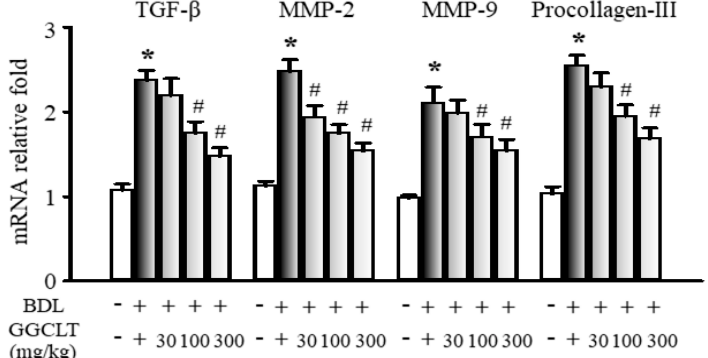
Figure 5. E ff ects of GGCLT on hepatic fibrotic signaling in BDL mice. The quantitative real-time PCR results show the mRNA levels of TGF- β , matrix metalloproteinase-2 (MMP-2), MMP-9, and procollagen-III in the liver tissues. The data presented are the mean ± SEM from three independent measurements. * p < 0.05 vs. sham-control mice; # p < 0.05 vs. BDL mice.